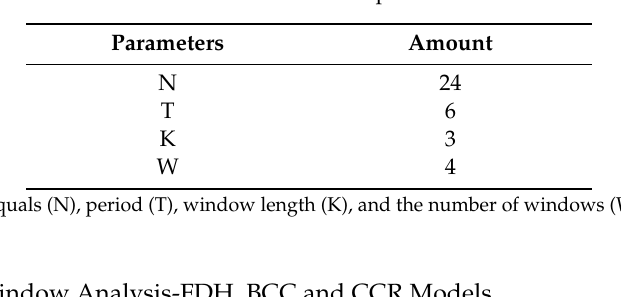
Table 4. Values of model parameters.